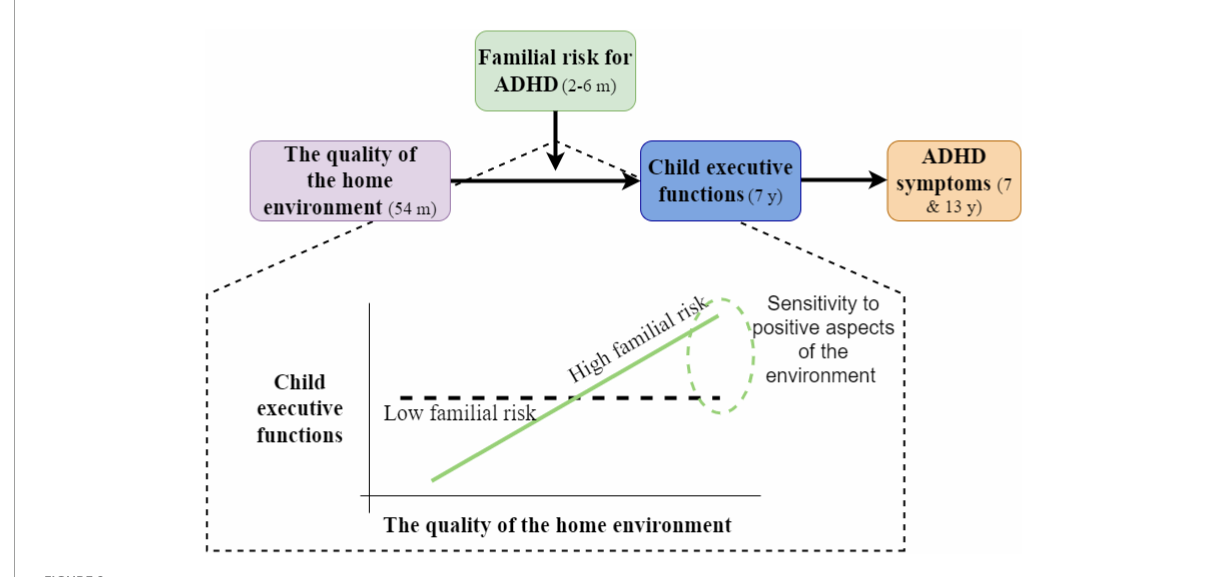
FIGURE2 Schematic description of the findings in Einziger et al.